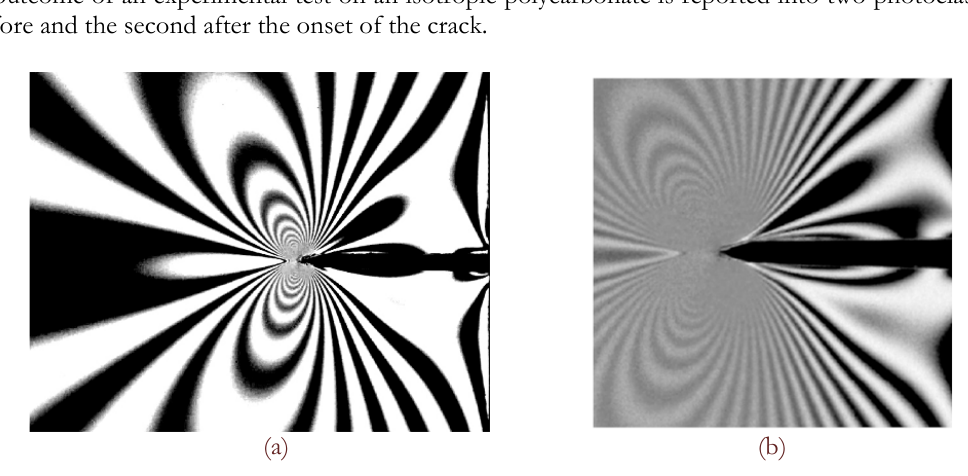
Figure 9: Photoelastic images for a straight crack in Mode I. Fringe pattern before cracking (a) and after cracking (b). From Al Bin Mousa [13].